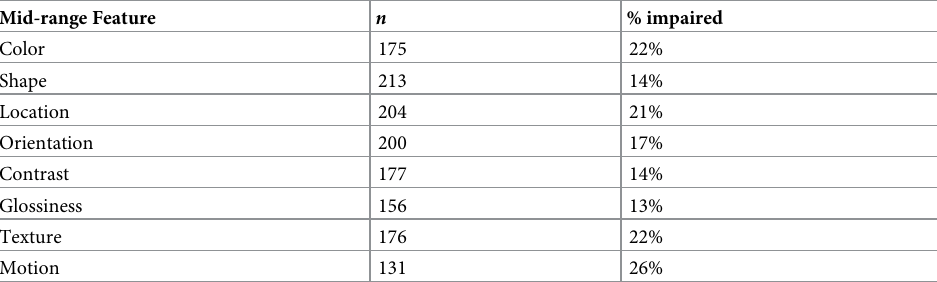
Table 3. Frequencies of mid-range visual deficits (in percentages).